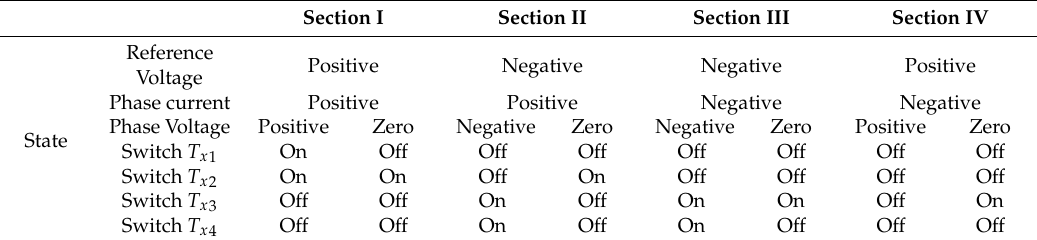
Figure 9. The switching signal and reference voltage whole waveforms of the proposed ZDPWM method. Table 2. Switching state of the proposed ZDPWM depending on the section.